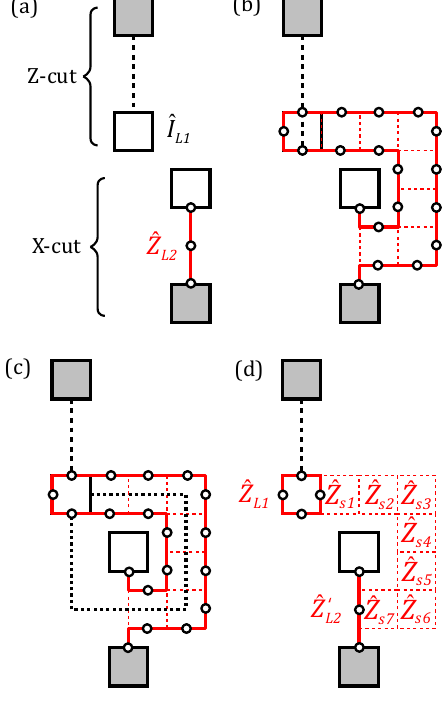
⊗ Z . (a) Prior to the move, displaying I L 1 L 2 , with the exception of possible sign changes. L 2